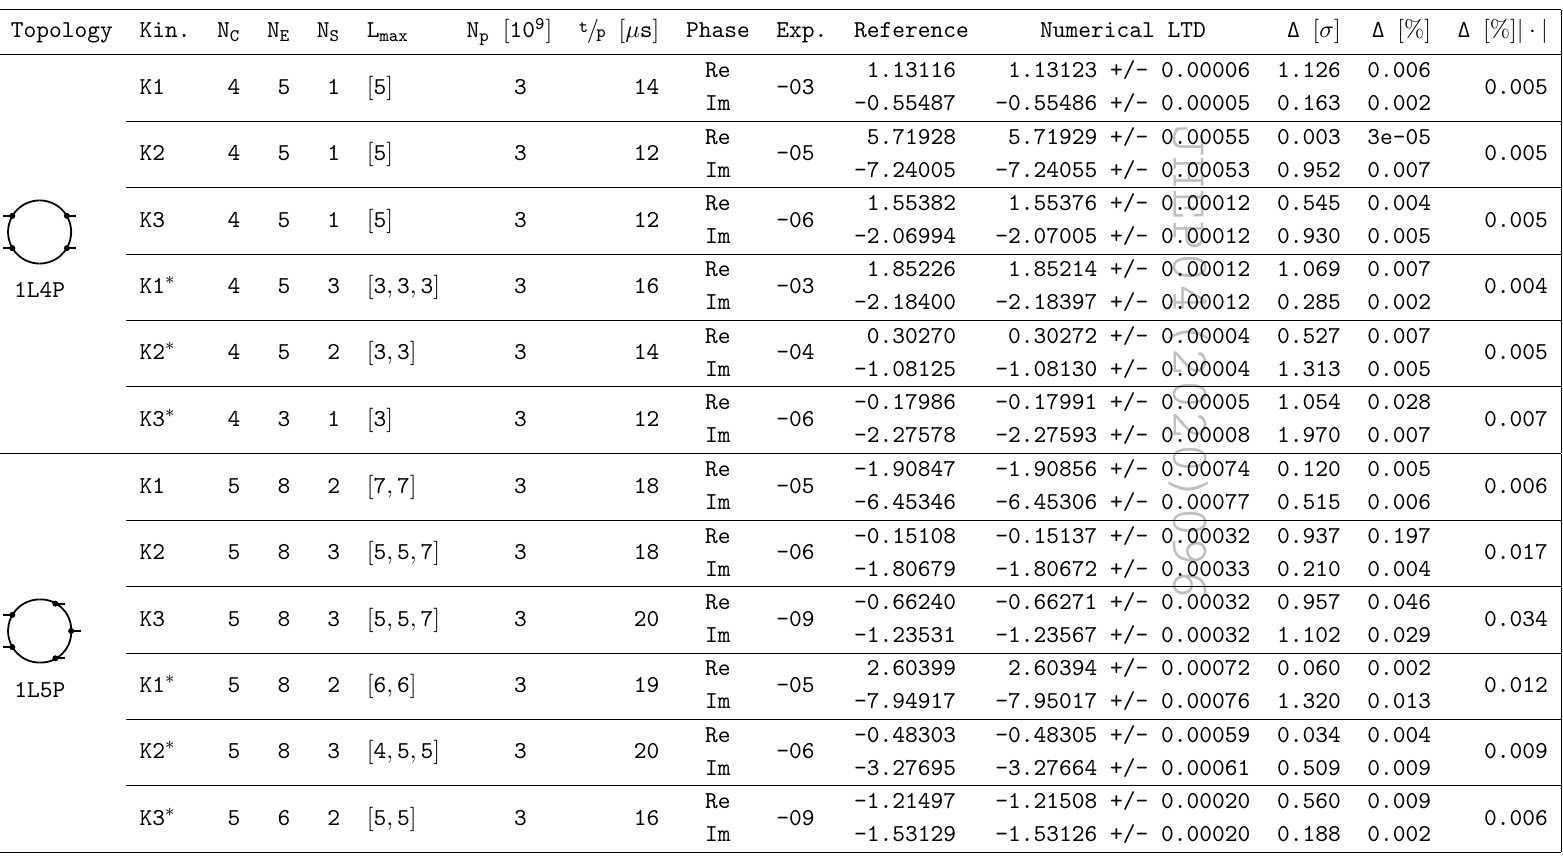
Results for one-loop four-point and (cid:12)ve-point topologies for scattering kinematics (2 (indicated by a * ). See the main text for